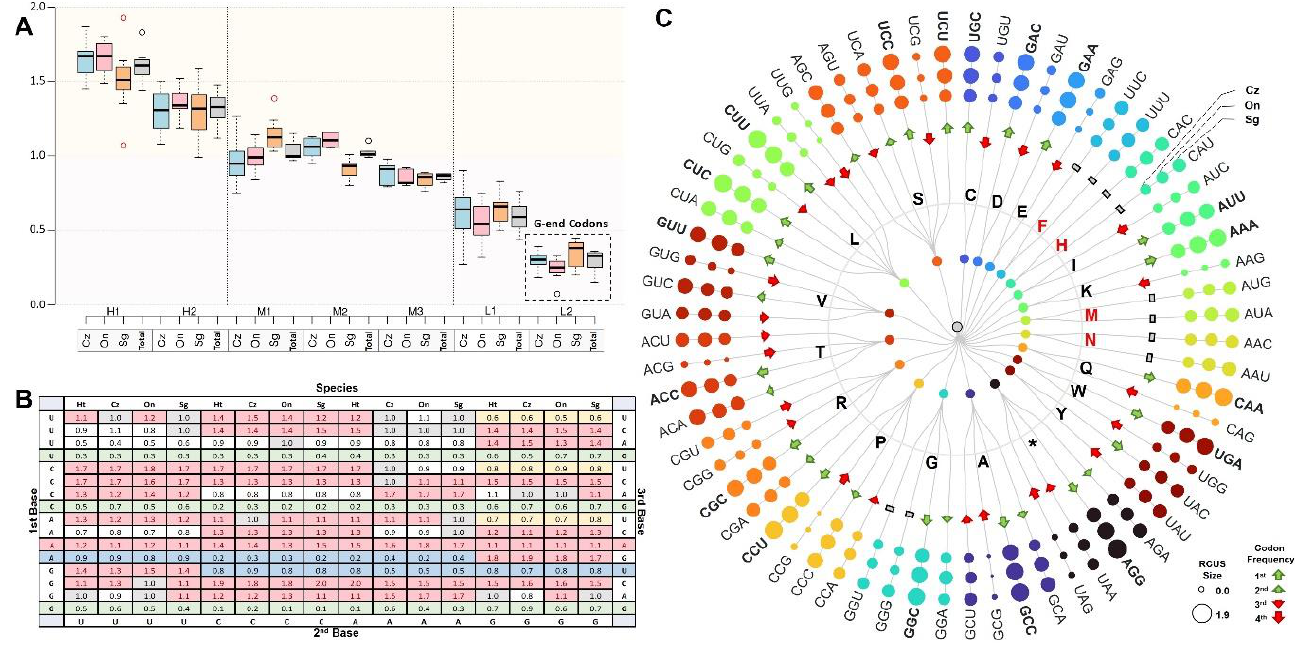
Figure 4. ( A ) The box plot representing the clustering analysis of codon usage bias based on the RSCU values. The highest RSCU values clustered in H1, while the lowest in L2. Each color represents a species, blue represents C. zillii , red represents O. niloticus , orange represents S. galilaeus , and gray represents the total average of RSCU values for the three species. ( B ) The relative synonymous codon usage (RSCU) patterns of 13 PCGS between the Nile tilapiine species. Each color represents several codons based on the RSCU values: red represents codon bias RSCU values > 1, gray represents codons showing no bias RSCU values = 1, green represents codons’ relative rarity RSCU values < 1, yellow represents codons bias against specific codons, and light blue represents codons bias against all codons except one codon. ( C ) The circular dendrogram represents synonymous codon usage for coding 20 amino acids. The amino acids are described with a one-letter abbreviation. The size of the circles represents the RSCU value that ranged from 0.00 to 1.90. Biased codons are marked with the green arrow (more abundant), while biased-against codons are marked by the red arrow (less abundant), and codons that showed no bias are marked by a gray rectangle.